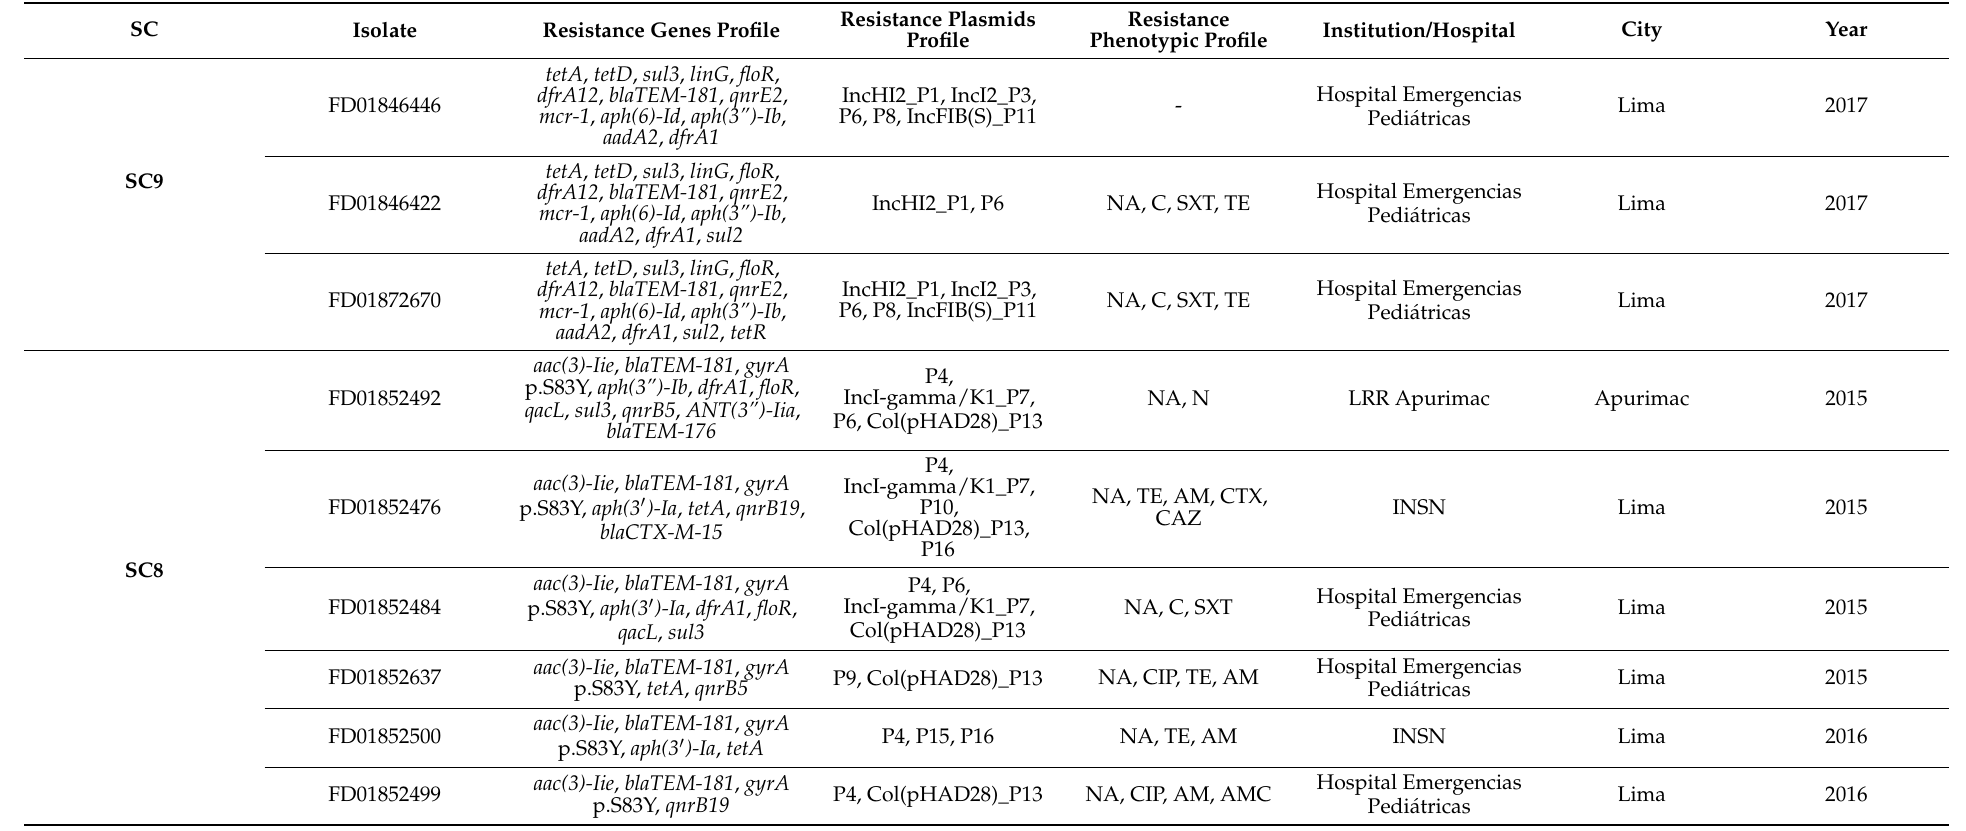
Table 2. Profile of 50 Peruvian drug resistance isolates (44 phenotypically and 4 genotypically resistant to 10 tested drugs, and 2 genotypically resistant to untested